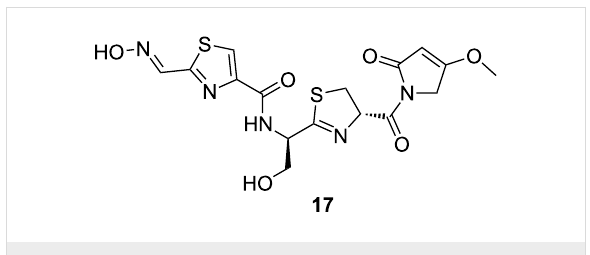
Figure 4: Structure of althiomycin ( 17